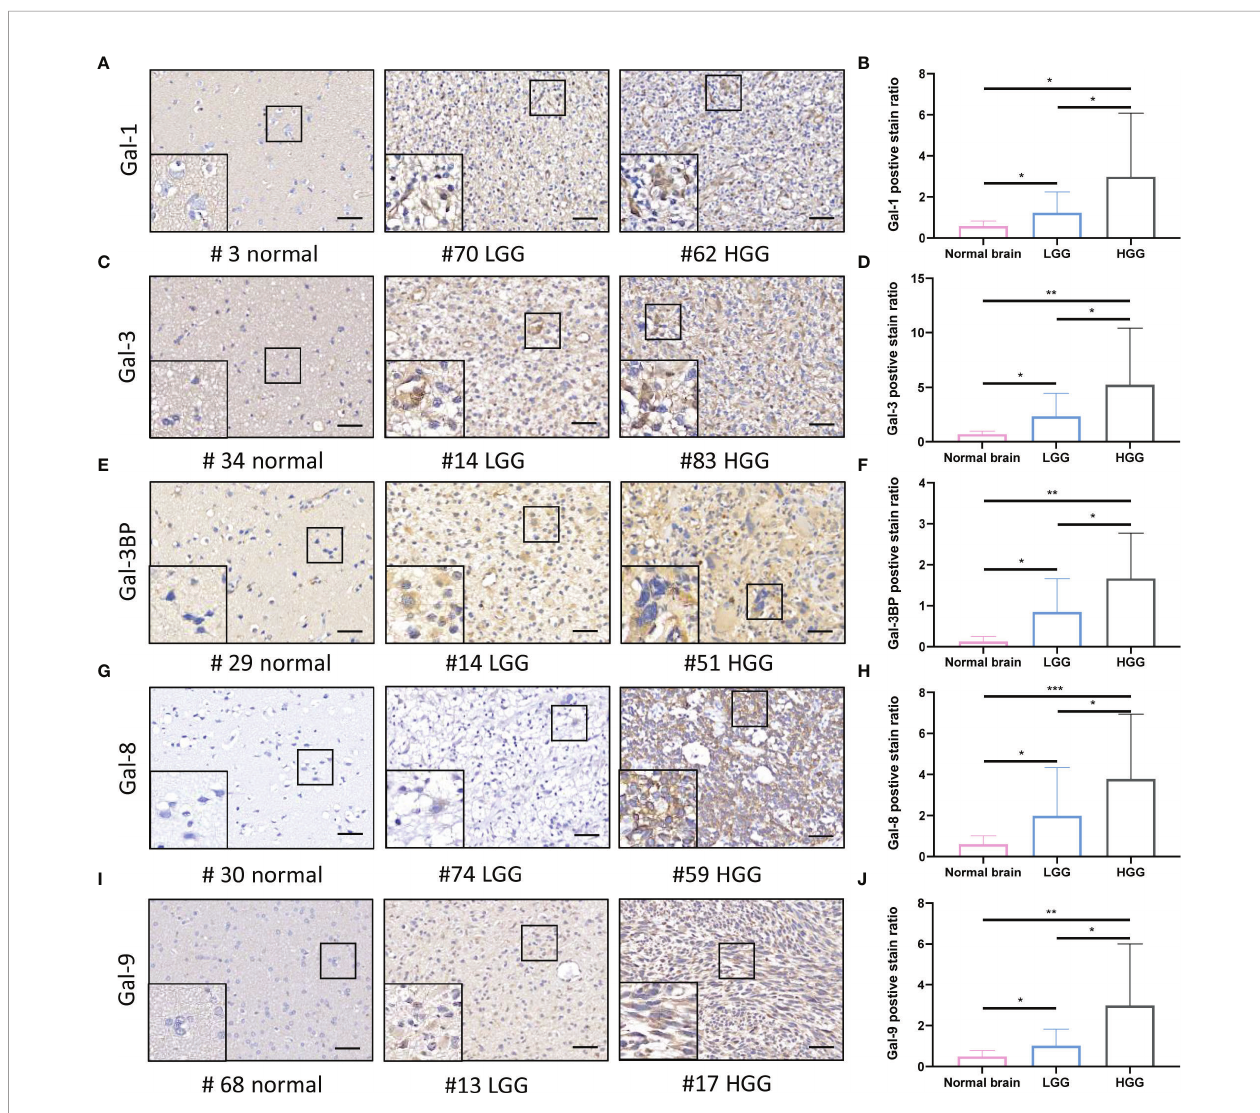
FIGURE 3 | Galectin expression levels in the human normal brain and LGG and HGG tissues as shown by IHC staining. (A) Immunohistochemical staining of Galectin1 (Gal-1) in glioma patients TMA. Representative staining images of the normal brain; LGG and HGG are shown. (B) The positive stain ratio of Gal-1 in TMA glioma specimens, the statistical chart of Figure 3A . Similarly, the representative IHC staining images of Gal-3 (C) and statistical chart of its positive stain ratio (D) , the representative IHC staining images of Gal-3BP (E) and statistical chart of its positive stain ratio (F) , the representative IHC staining images of Gal-8 (G) and statistical chart of its positive stain ratio (H) , the representative IHC staining images of Gal-9 (I) , and statistical chart of its positive stain ratio (J) were shown. The scale bar measures 40 m m. IHC, immunohistochemistry; HGG, high-grade glioma; LGG, low-grade glioma *p<0.05, **p<0.01,